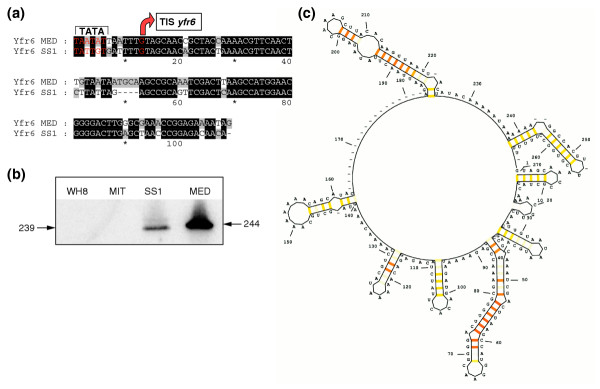
Characterization of a gene encoding Yfr6. (a) Sequence alignment of the region containing the transcriptional initiation site (TIS) and the first 97 transcribed nucleotides of Yfr6 from MED4 and SS120. The alignment begins with the TATA element (in red) preceding the mapped first transcribed guanidine (labelled by an arrow). (b) In Northern blots, a signal for the predicted Yfr6 was detected for 244 and 239 nucleotides in total RNA from MED4 (MED) and SS120 (SS1), respectively, but not in RNA from WH 8102 (WH8) and MIT 9313 (MIT). (c) Comparison of Yfr6 secondary structures using ConStruct version 3.0a [60] The base pairing probability is colour-coded from light yellow (low) to red (high). Missing positions are indicated by a dash. The predicted RNA structures were obtained by RNAfold at 24°C. Both sequences were equally weighted (1.0). The consensus was calculated based on the predicted optimum structures. Default parameters were used for all other options.